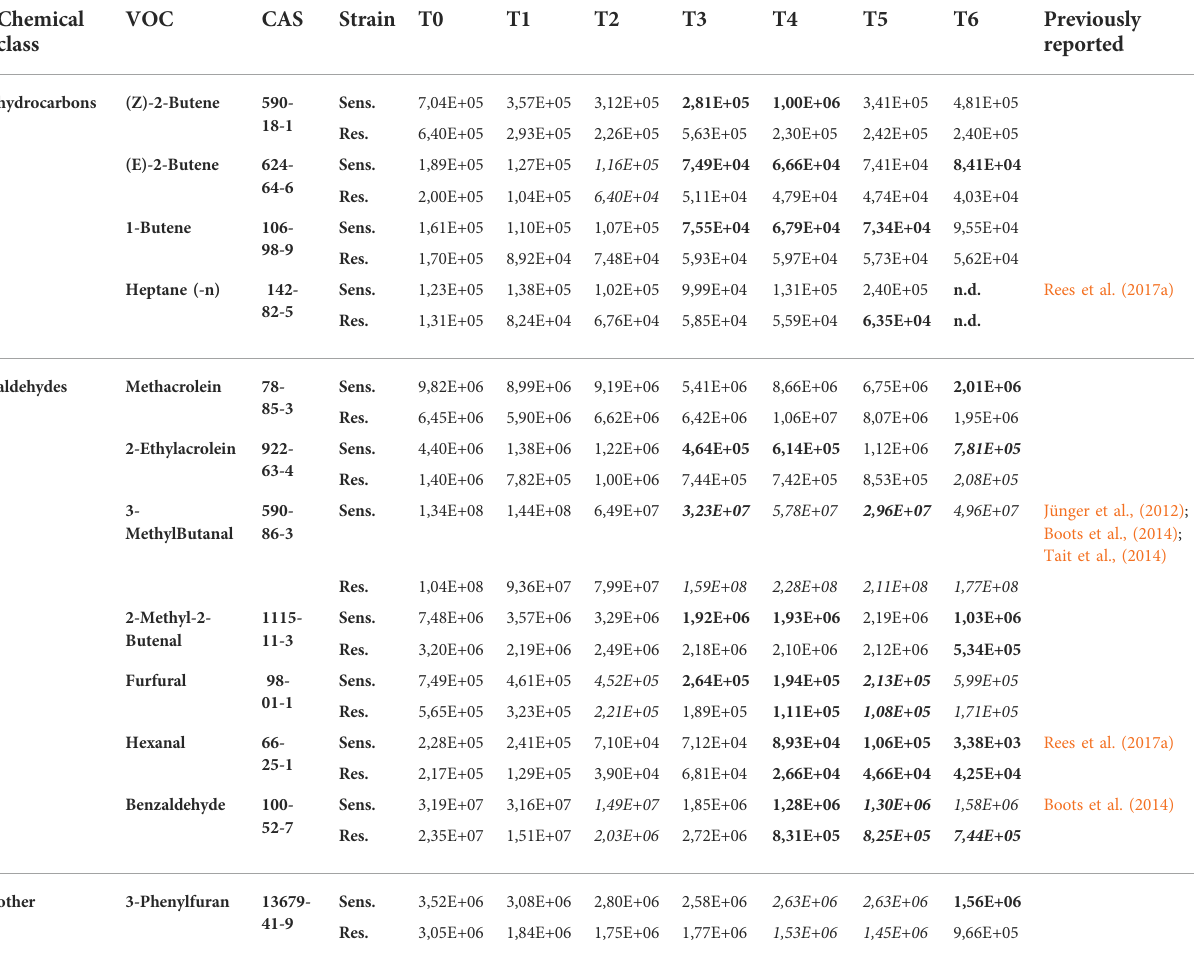
Table legend: Sens ., a sensitive strain of KPN; Res ., a resistant strain of KPN; bold value of peak area , indicates the statistically signi fi cant difference (Kruskal-Wallis test) between the timepointofinterestand T0. Underlineditalicvalueofpeak area ,indicatesthestatisticallysigni fi cantdifference(U-Mann-Whitneytest) betweenresistantandsensitivestrainat thesame